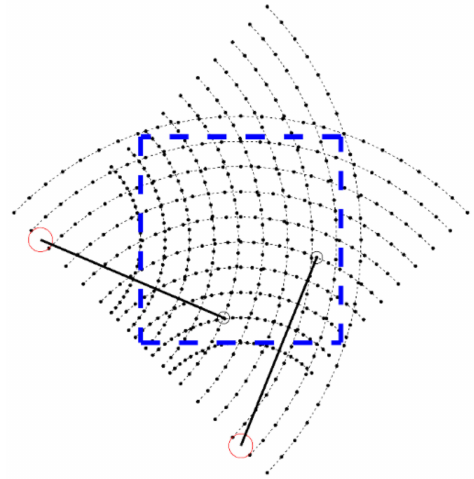
Figure 2. The dual-LiDAR unsynchronised PPI scan. The square with dashed blue line represents the sensing area. The black dots and the dashed line represent the scanning points and trajectories, respectively. The two red circles indicate the positions of LiDAR. The black line and circle represent two LoS measurements of two LiDAR at the same